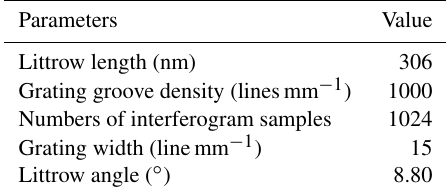
Table 2. Instrument parameters for